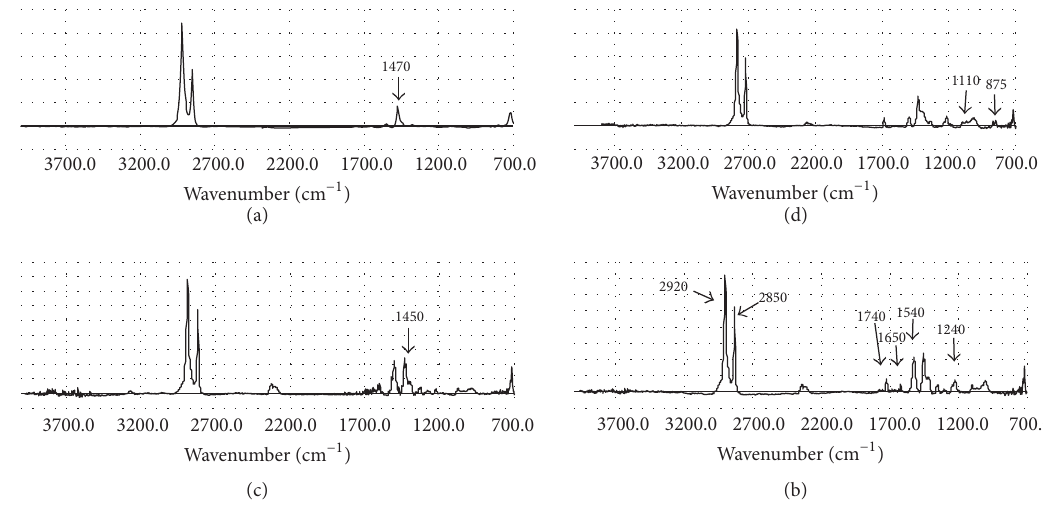
Figure 3: IR spectra of the five-layer film, virgin (a), aged for 8 hours by sand wind at 40 ∘ C (d), aged for 1000 hours at 40 ∘ C (b), and aged for 1000 h by UVA at 40 ∘ C